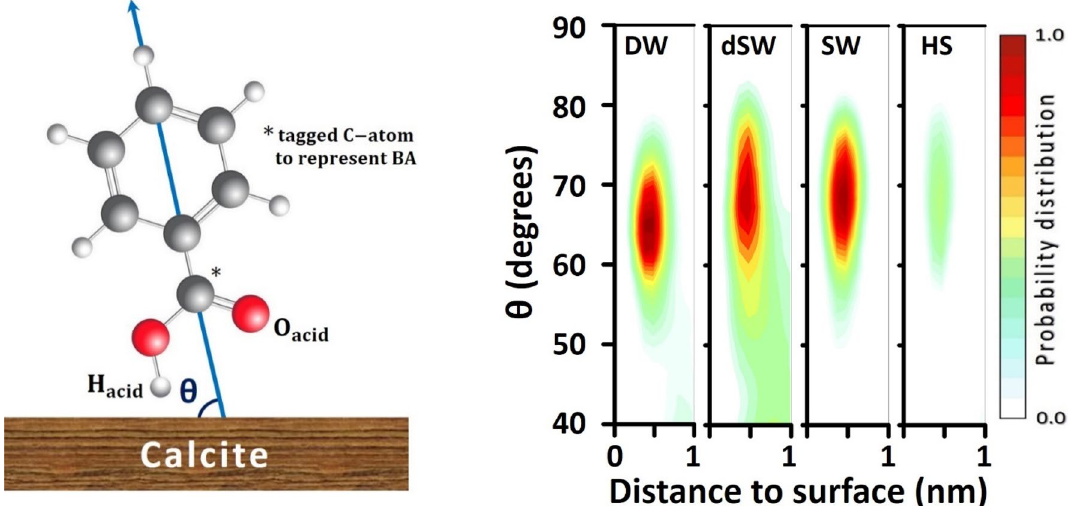
Figure 6. The schematic representation of inclination angle, θ, (left) and the distribution of θ over calcite surface